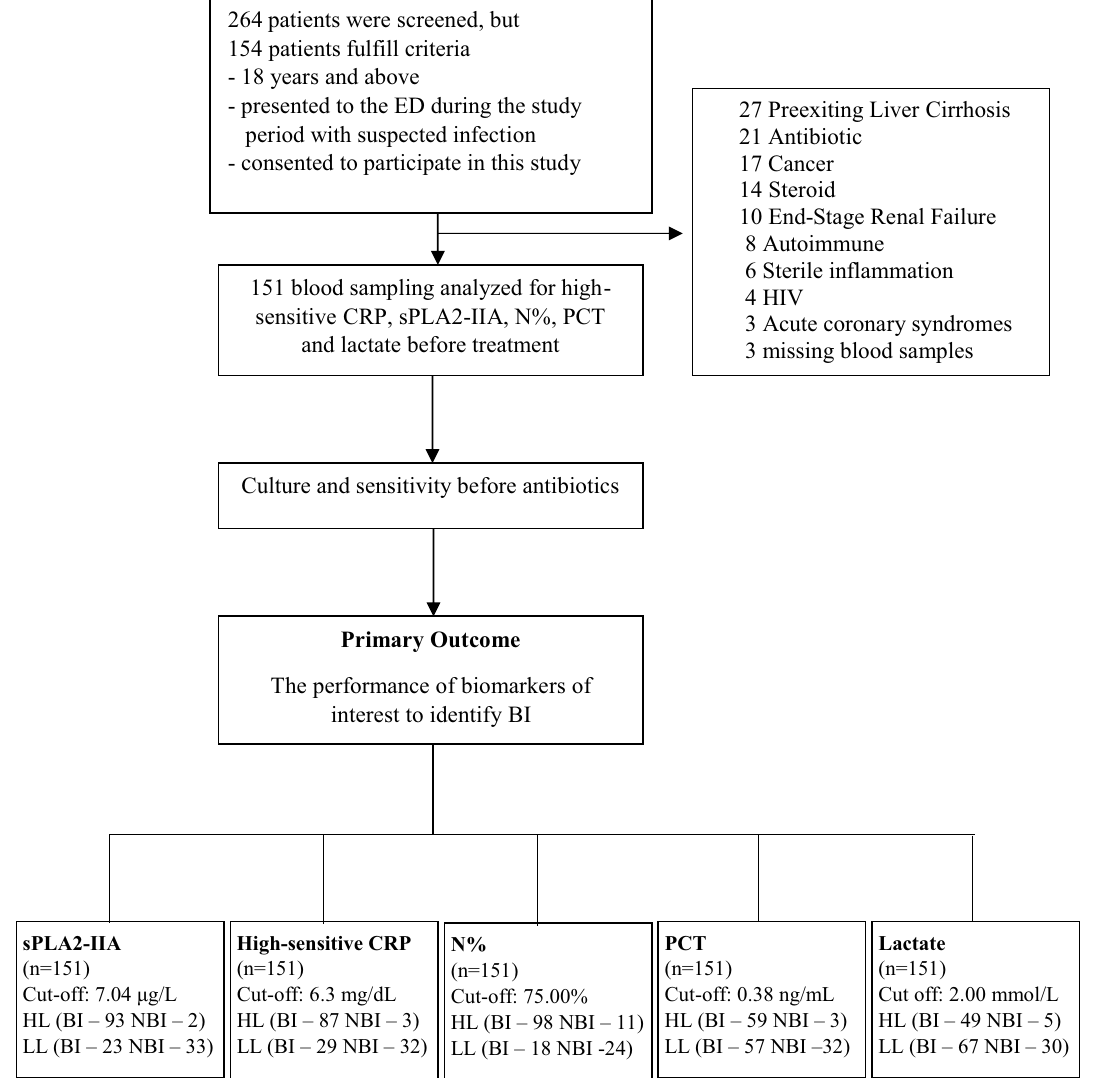
Figure 1. Study on-site recruitment and workflow (May 2015–October 2017). High-sensitive CRP = High- Sensitive C-Reactive Protein; sPLA2-IIA = Secretory Phospholipase 2- IIA; N%, = Neutrophil Percentage; PCT = Procalcitonin; HIV = Human Immunodeficiency Virus; ESRF = End-Stage Renal Failure; BI = Bacterial Infection; NBI = Non-Bacterial Infection; HL = High Level*; LL = Low Level † . *High level refers to biomarker’s level that equal to or higher than the cut-off point. † Low level refers to biomarker’s level that equal to or lower than the cut-off